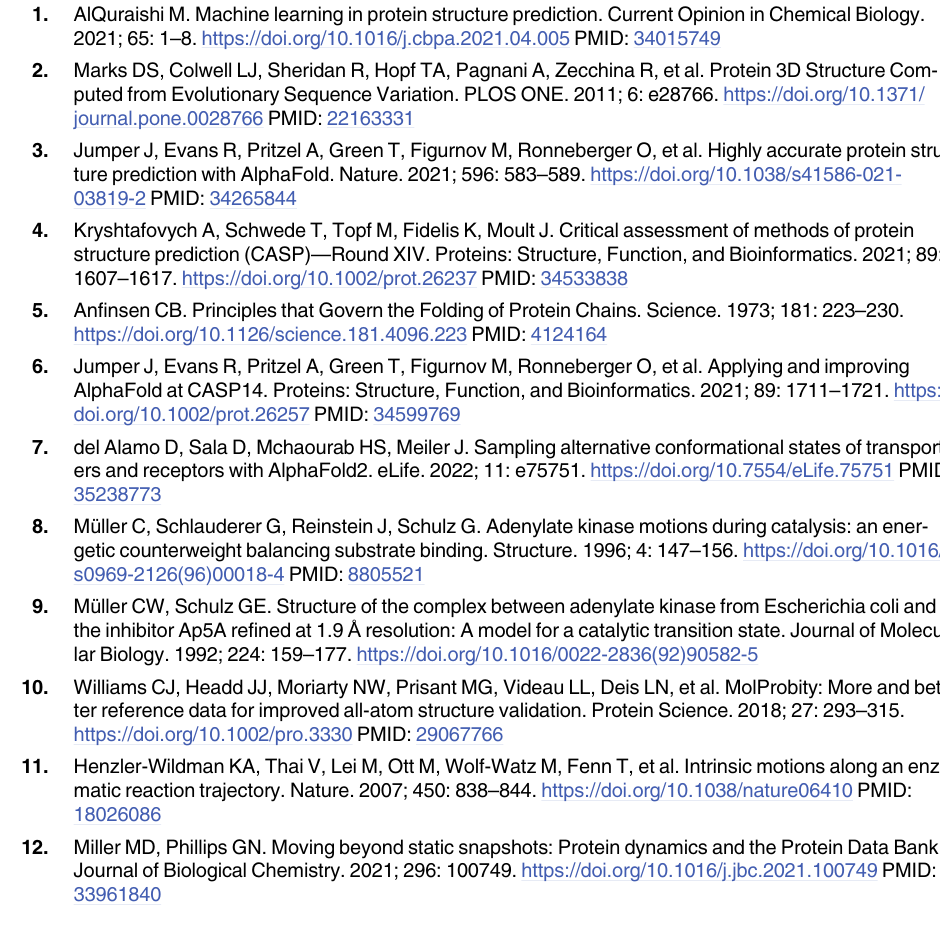
Ribose Binding Protein. Fig C: Structures outside the transition from 2dri to 1ba2 are not mis- folded. Fig D: Plots matching models to experimental structures. Fig E: Conformation diver- sity of the models. Fig F: Plots matching models to experimental structures. Fig G: Analysis of MurJ without transmembrane helices 13 and 14. Fig H: PfMATE conformational flexibility. Fig I: LmrP conformational flexibility. Fig J: PCA of Adenylate Kinase. Fig K: SPEACH_AF on ubiquitin.